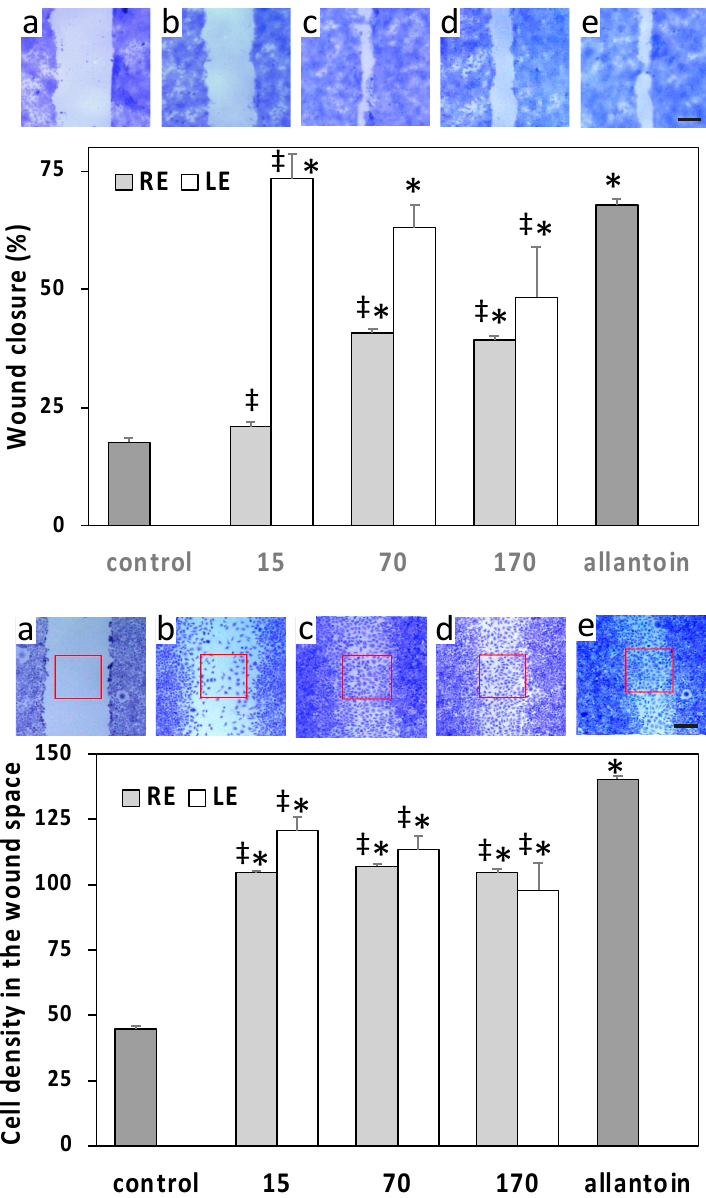
Figure 5. Scratch wound assays conducted on HaCaT human keratinocytes (top panel) and L929 mouse fibroblasts (bottom panel) exposed to different concentrations of LE or RE ( µ g/mL). Micro- graphs show representative wounded cell monolayers at different times after wounding and under different conditions (bar = 250 µ m). Data of HaCaT are expressed as means ± S.D. ( n = 49–67) of percent wound closure at 24 h. Data of L929 are means ± S.D. ( n = 8) of the normalized cell densities within the wound space (number of cells per unit area; red squares in micrographs) at 24 h post wounding. a = wound space just after scratch wounding; b = control at 24 h; c = 15 µ g/mL LE at 24 h; d = 70 µ g/mL RE at 24 h; e = positive control allantoin at 24 h; * = significantly different from control; ‡ = significantly different from allantoin ( p <